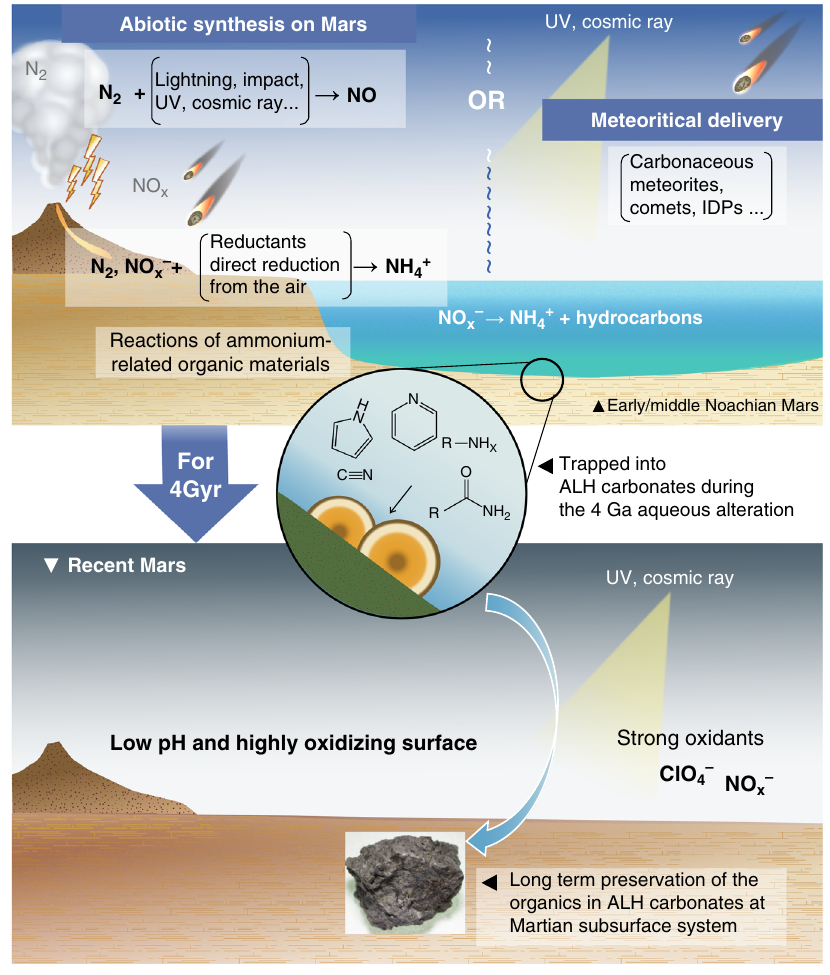
Fig. 3 Possible history for the Martian N-bearing organics. Nitrogen-bearing organic matter was either synthesized locally or delivered meteoritically on the early Mars. The former case requires an abiotic reduction of N (e.g., N 2 , NO x → NH 3 ) to start the ammonia-related chemical reactions. The latter case is also possible if adequate amounts of N-bearing components were supplied. This organic matter survived in the 4 Ga Martian (near)surface fl uids and was trapped into ALH carbonates during precipitation. The carbonates resided in the subterranean system, preserving the organic components over long geological